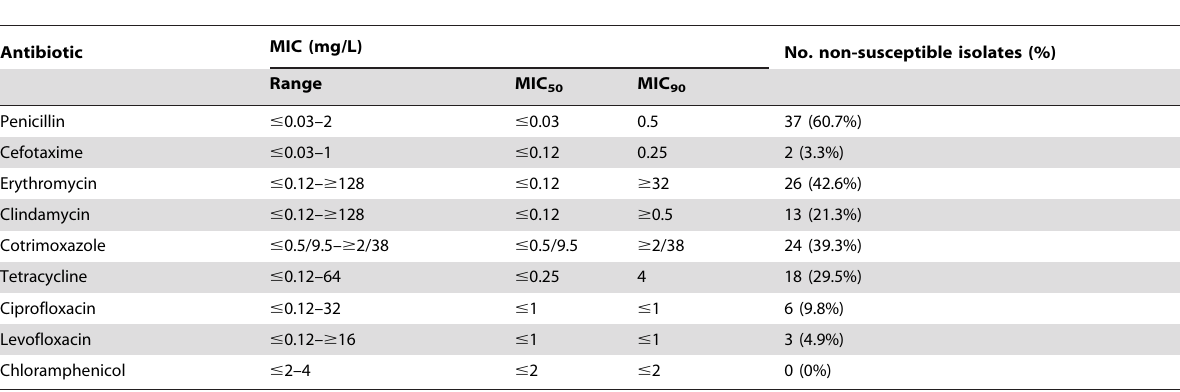
Table 2. Antimicrobial susceptibility of 61 S. pseudopneumoniae clinical isolates.